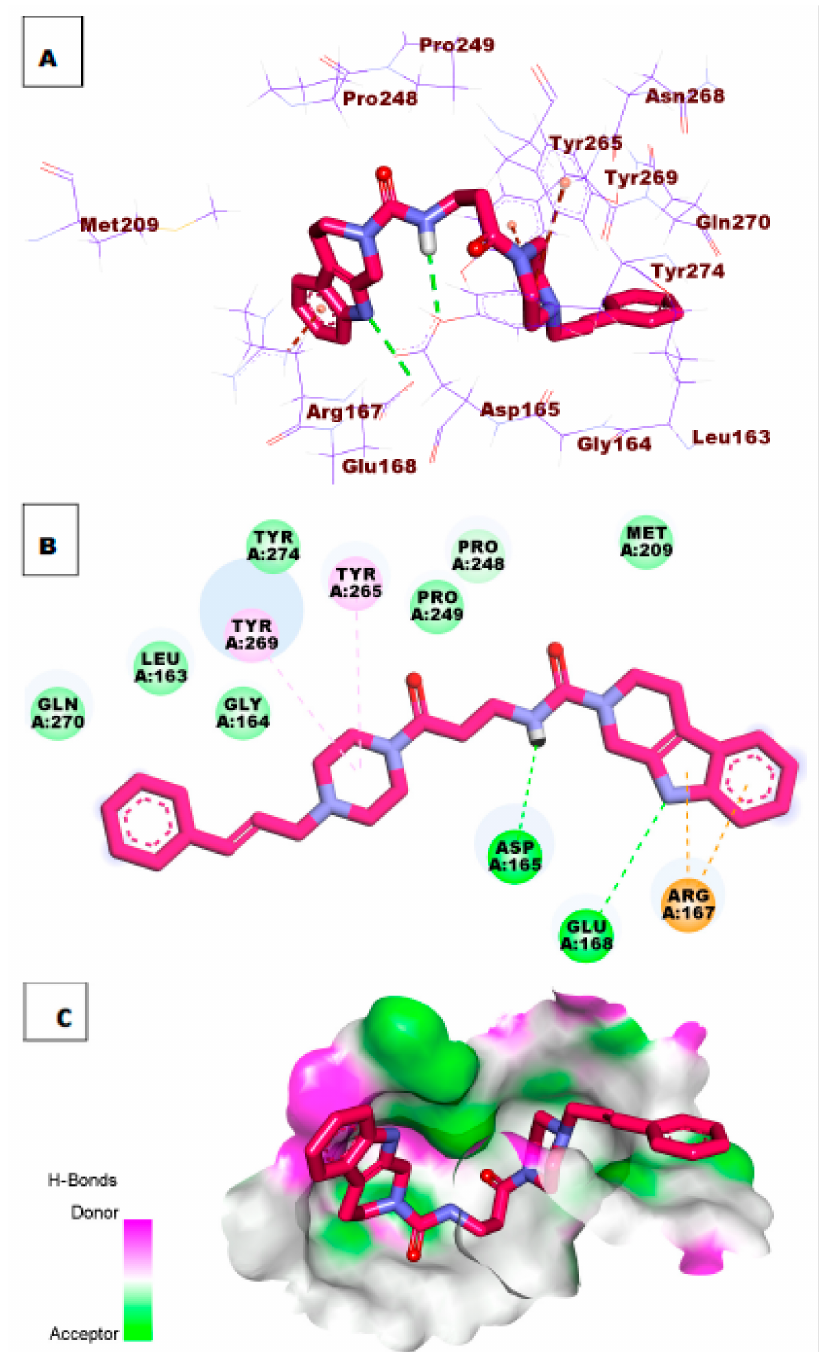
Figure 5. ( A ) 3D of S88 docked into the active site of PLpro. ( B ) 2D of S88 docked into the active site of PLpro. ( C ) Surface mapping of S88 docked into the active site of